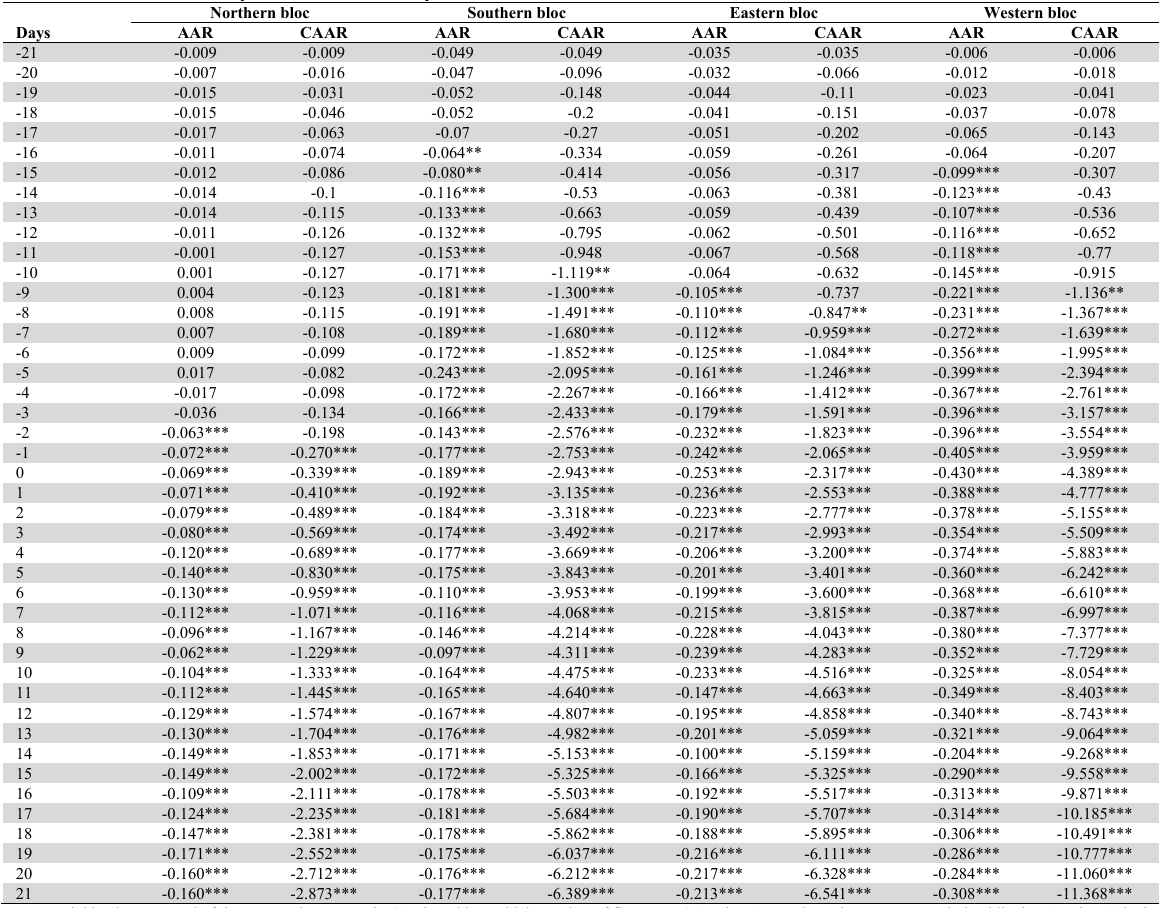
AARs and CAARs 21 days before and 21 days after the event of confirmed COVID-19 deaths Northern bloc Southern bloc Eastern